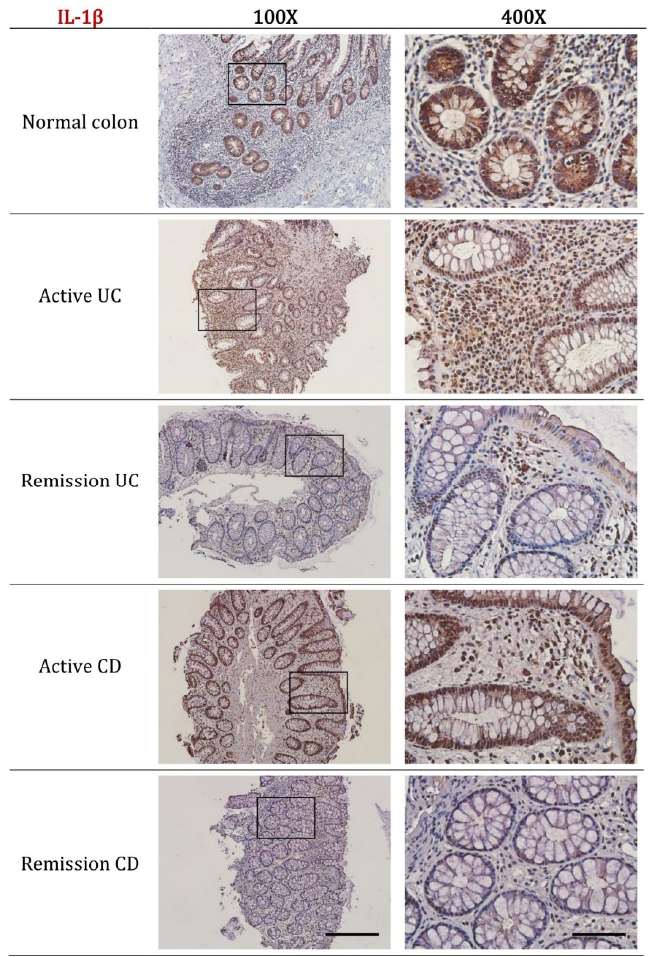
Figure 3. Representative immunohistochemistry images of IL-1 β expression in normal colon, active UC, remission UC, active CD and remission CD. All biopsies were taken from the left colon (unless stated as ileum biopsy), paraffin embedded, cut into 5 μ m sections and incubated with IL-1 β (ab9722, Abcam, Cambridge, MA, USA) at a dilution of 1:300. Disease diagnosis was confirmed by a practicing pathologist. Scale bars represent 50 µ m for 400 × and 200 µ m for 100 ×